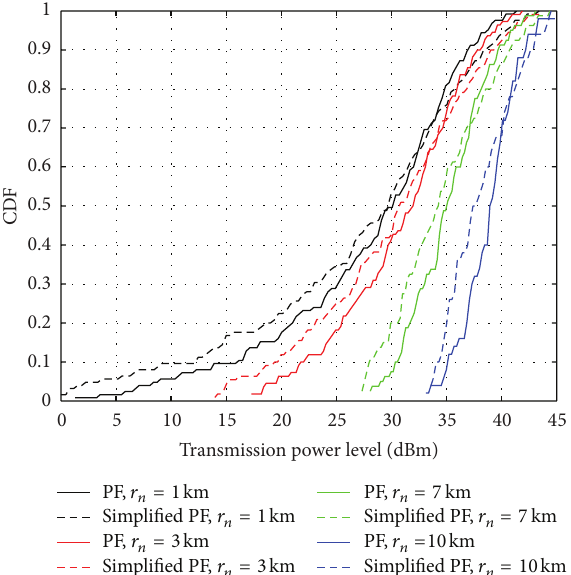
Figure 4: Distribution of transmission power levels by using PF and simplified PF schemes for different protection distances. The locations of secondary transmitters are fixed and